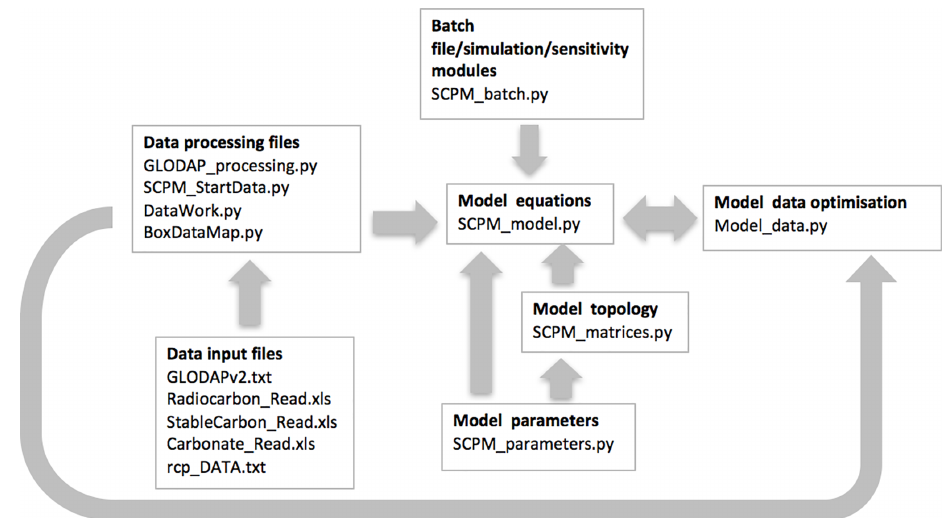
Figure 2. SCP-M Python and ancillary files with their linkages. Arrows refer to the direction of file linkages and the order of their activation during the routine of setting up and running the model. SCP-M is currently implemented in Python 3.6, although it has been run on other versions of Python. The folder or file structure separates model and data files. All files and user manuals are available from https://doi.org/ 10.5281/zenodo.1310161 (O’Neill et al.,